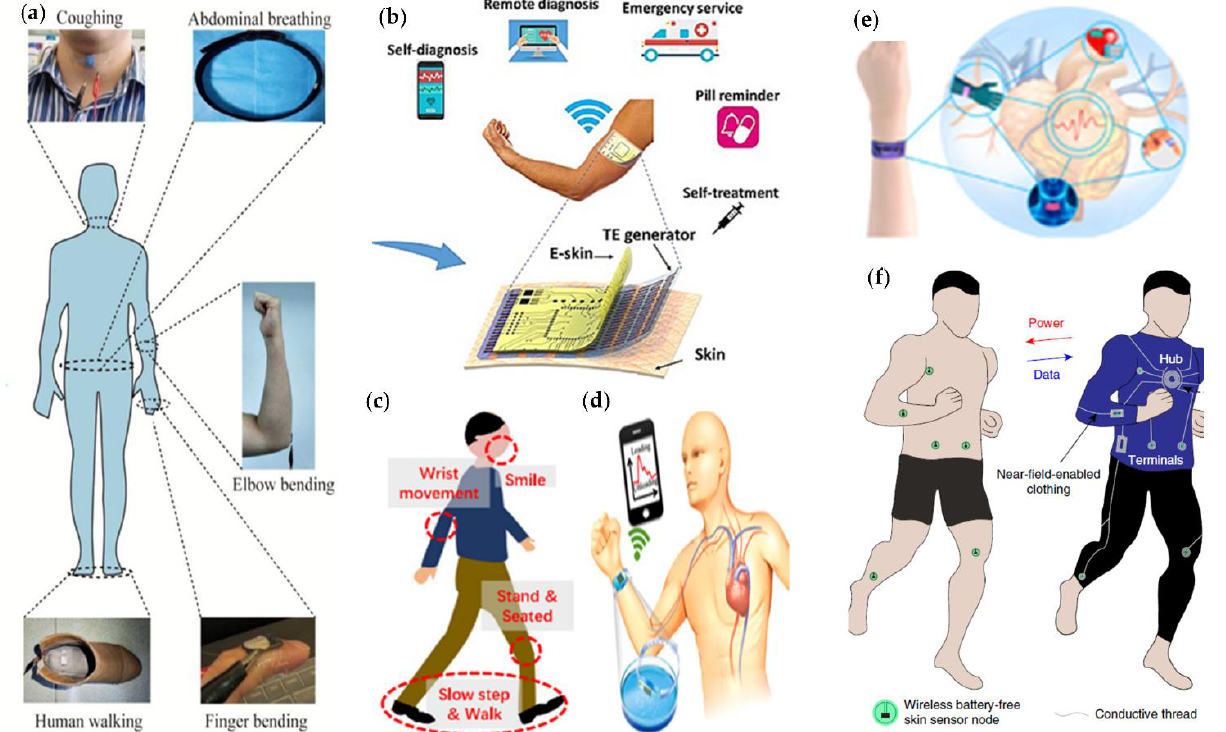
Figure 2. Flexible skin-like sensors for the human body. ( a ) An implantable and versatile piezoresistive sensor and